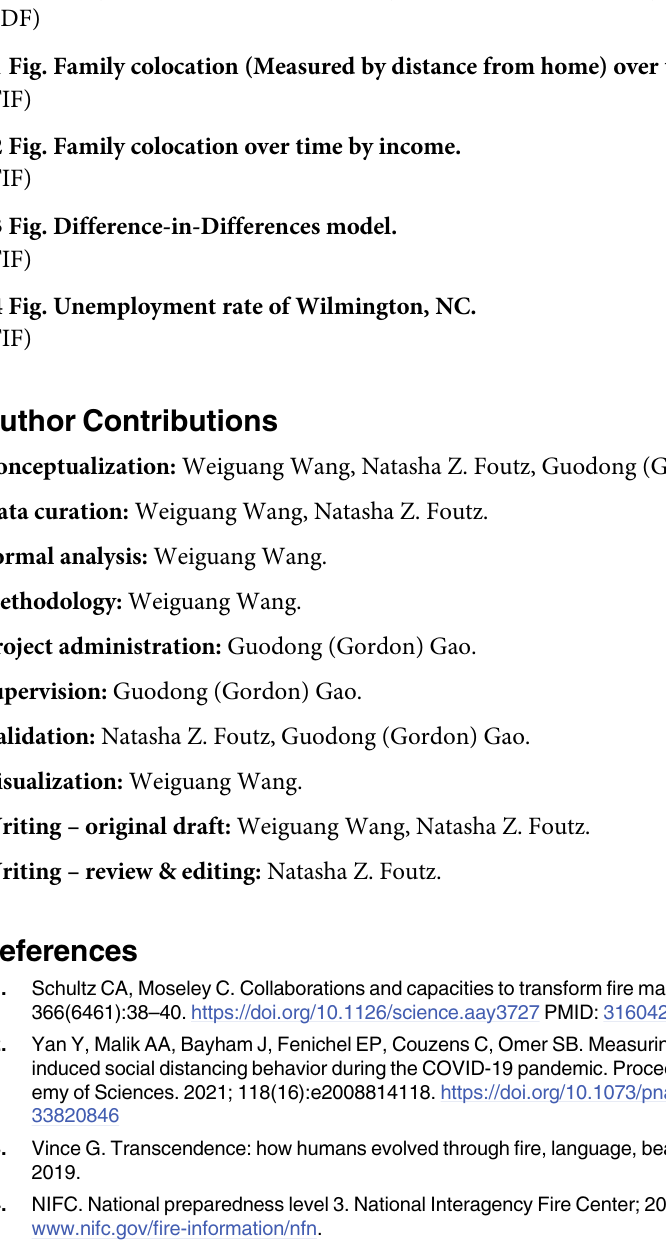
S4 Table. Alternative specification: Fractional logistic regression. S5 Table. Magnitude of the shift in family colocation: DV = Dummy. S6 Table. Dynamics in the shift in family colocation: DV = Dummy. S7 Table. Magnitude of the shift in family colocation (Measured by distance from home). S8 Table. Dynamics of the shift in family colocation (Measured by distance from home). S1 Fig. Family colocation (Measured by distance from home) over time.